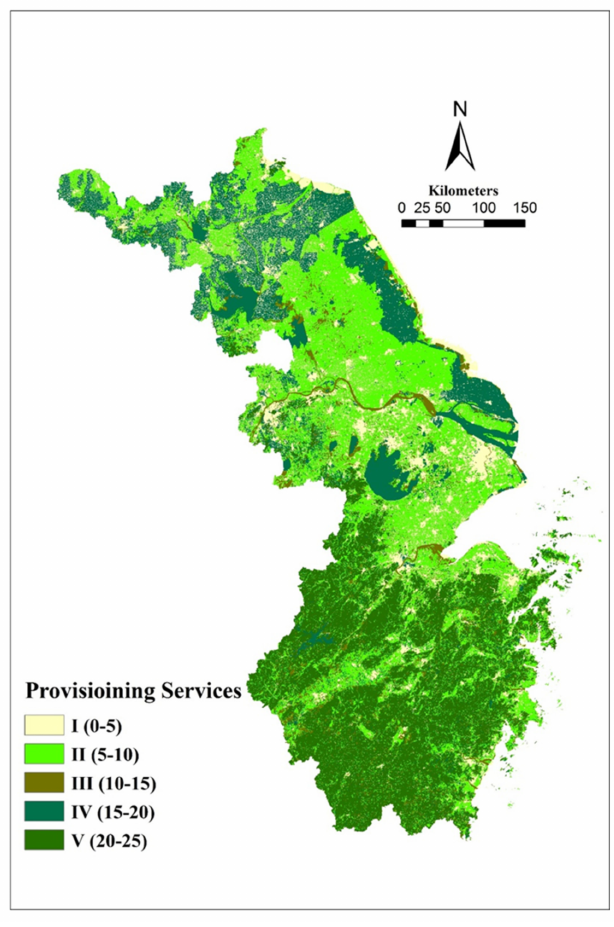
Figure 5. Spatial pattern and levels of provisioning services of